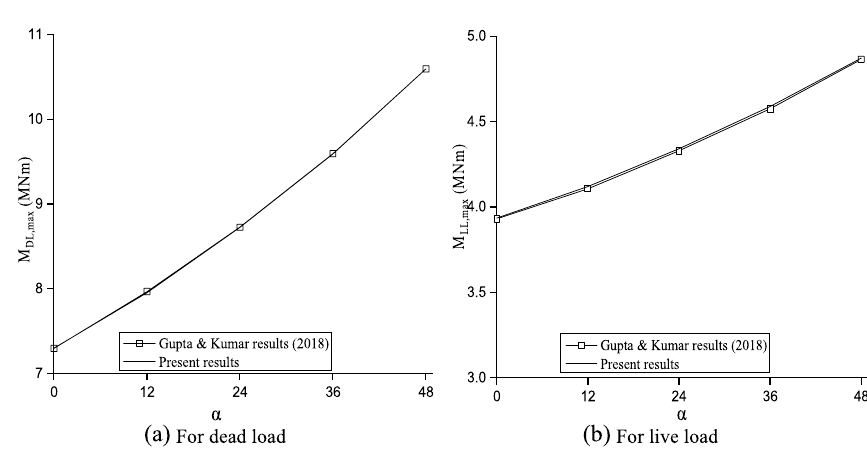
Fig. 3 Variation of MBM with curve angle in outer girder. a For dead load. b For live load